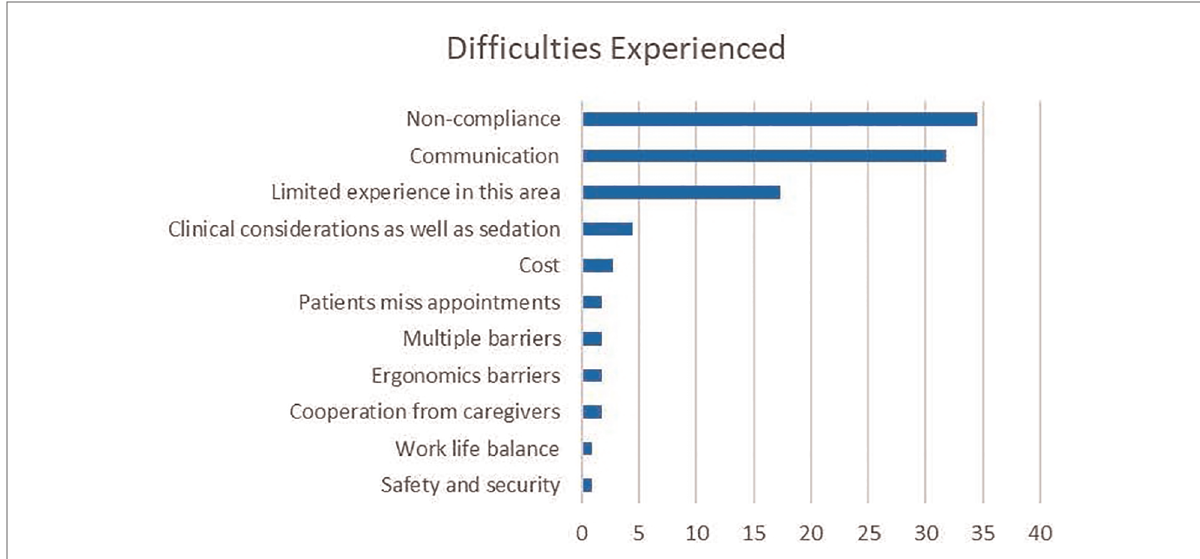
FIGURE 1 The most common themes on dif fi culties faced in treating patients with special